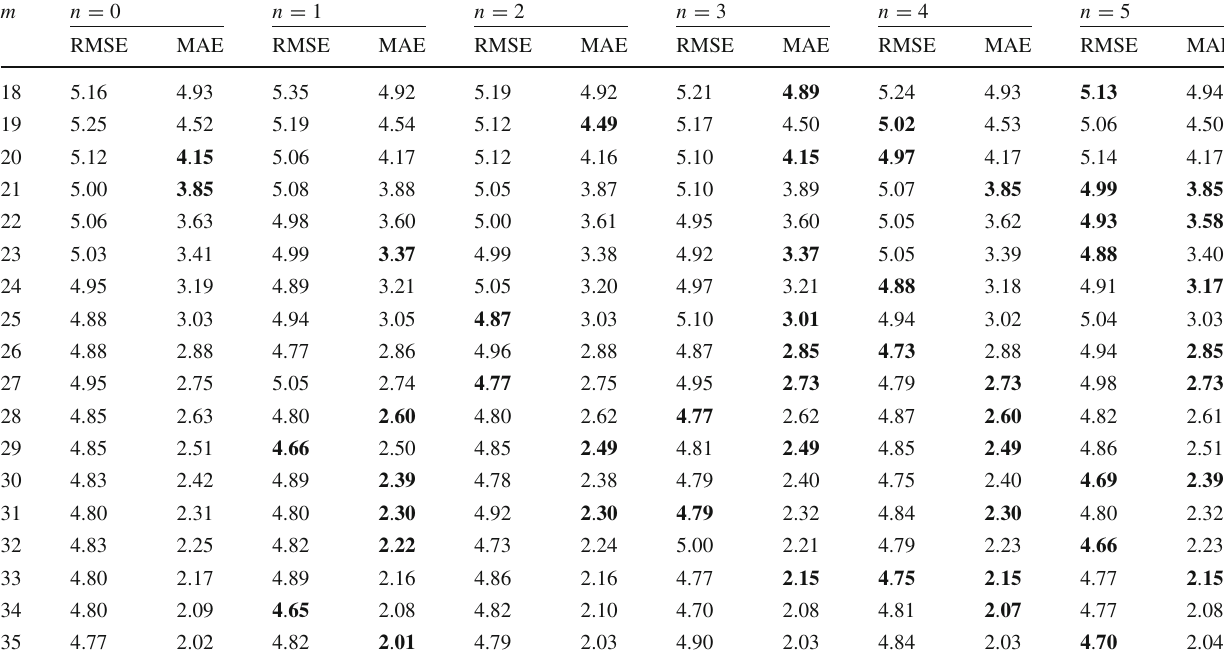
Table 3 Different number of regions with different number of